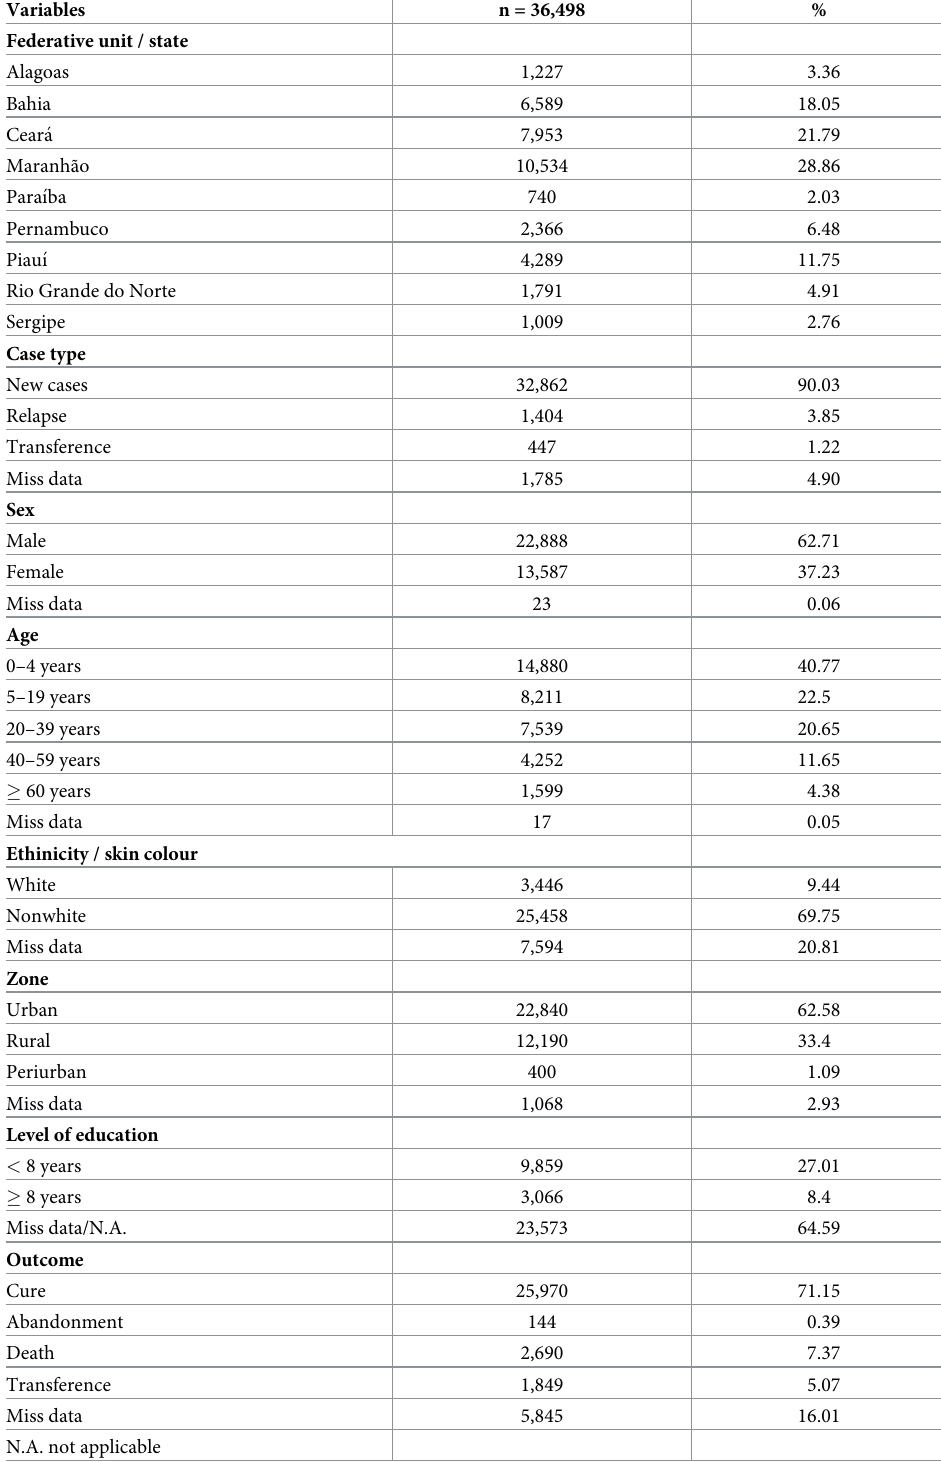
Table 2. Baseline